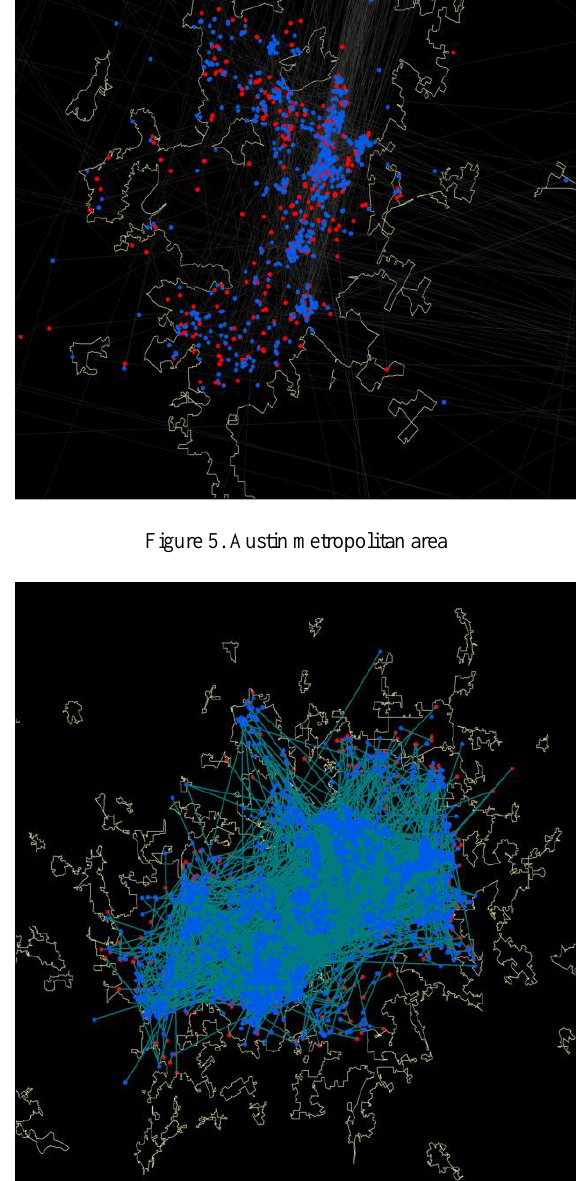
Figure 6. Dallas/ Fort Worth metropolitan